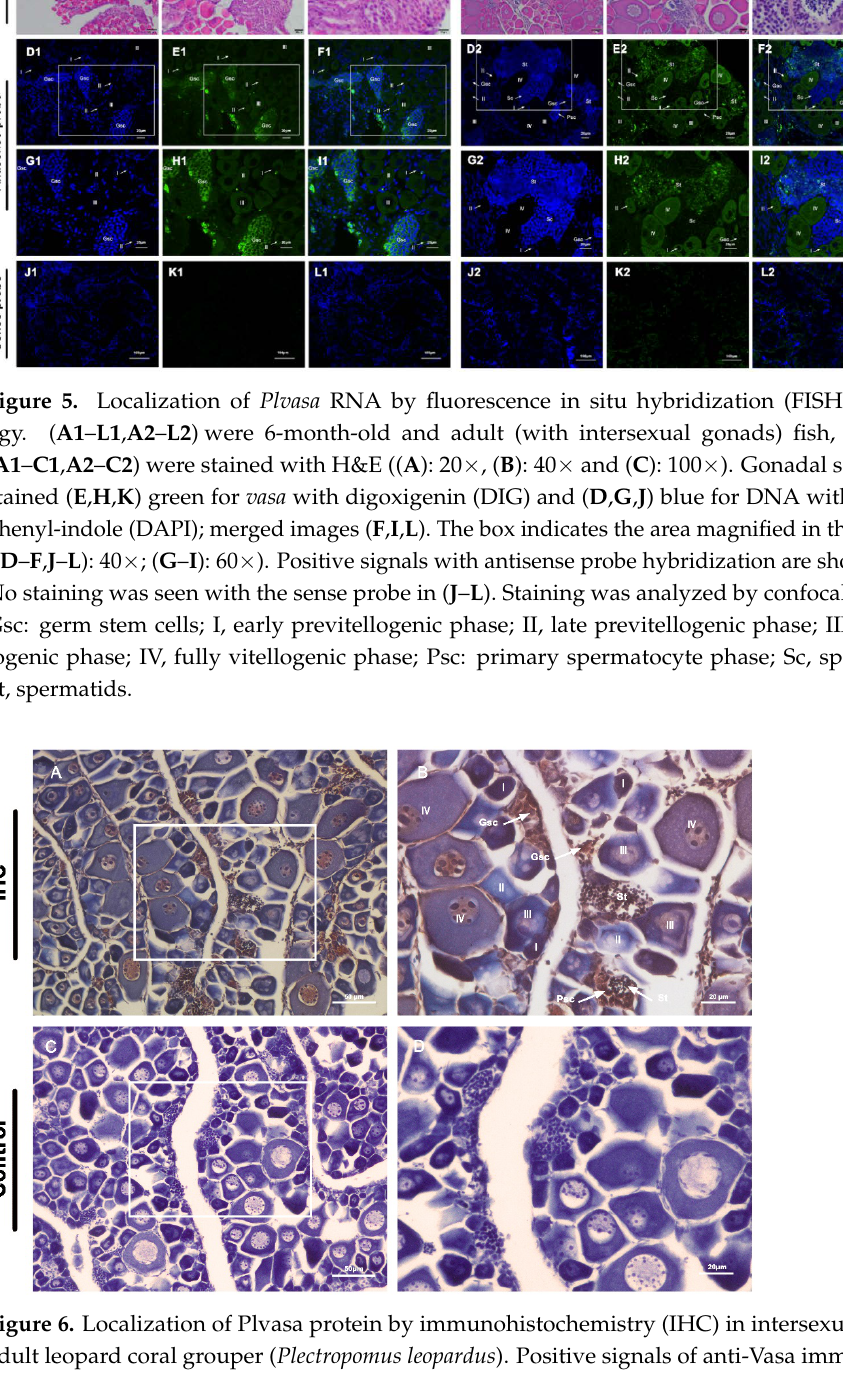
Figure 6. Localization of Plvasa protein by immunohistochemistry (IHC) in intersexual gonads of adult leopard coral grouper ( Plectropomus leopardus ). Positive signals of anti-Vasa immunolabeling are shown in tawny ( A , B ). Control groups are shown in ( C , D ). The box indicates the area magni- fied in the next frame (( A , C ): 20×; ( B , D ): 40×). Gsc: germ stem cells; I, early previtellogenic phase; II, late previtellogenic phase; III, early vitellogenic phase; IV, fully vitellogenic phase; Psc: primary spermatocyte phase; Sc, spermatocytes; St, spermatids.